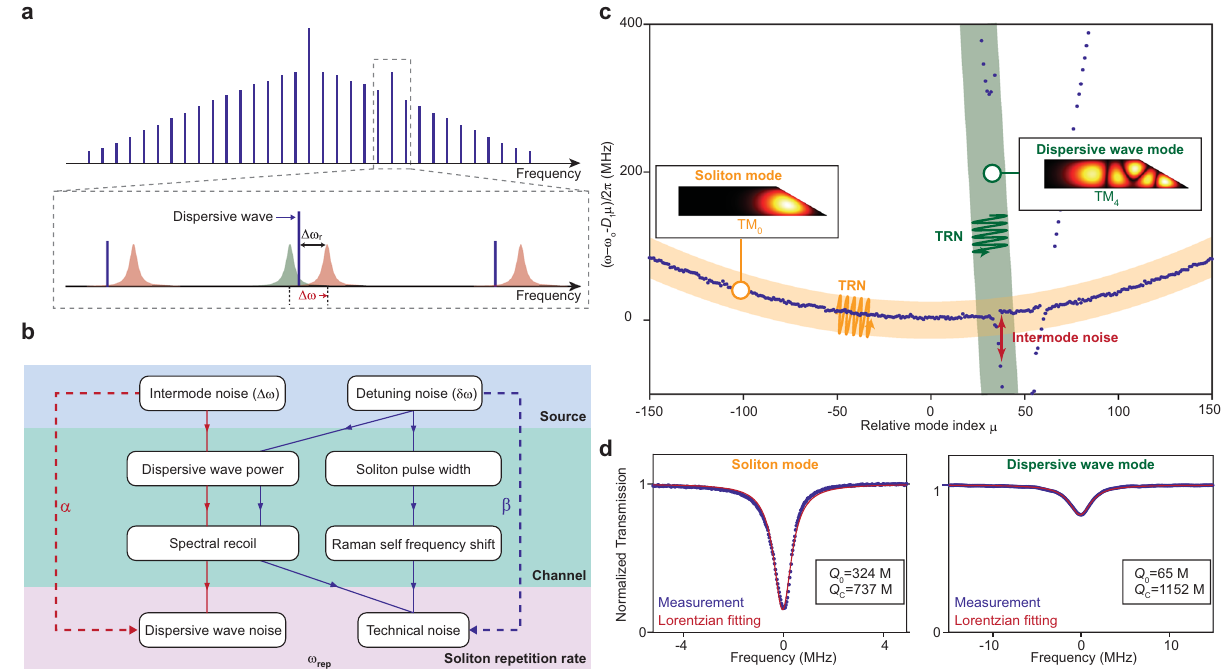
Fig. 4 Concept of dispersive-wave-induced noise and identi fi cation of mode families. a Spectral relationship of soliton spectrum to dispersive wave forming mode. Blue lines indicate soliton spectral lines. Red and green shaded regions denote soliton-forming and dispersive-wave resonator modes, respectively. b Left side: physical steps involved in coupling fl uctuations in Δ ω (intermode noise) into soliton repetition rate. Right side: physical steps involved in coupling fl uctuations in δω (detuning noise) into soliton repetition rate. Noise sources (top) are transduced ( α and β coupling channels) into the soliton repetition rate (bottom). Detuning noise results mainly from the pumping laser noise contributing to δω and thereby causes technical noise in the soliton repetition rate. Intermode noise results from fundamental thermo-refractive noise of the dispersive wave and soliton mode frequencies contributing to Δ ω . c Measured mode family dispersion of the microresonator. Numerically simulated cross sections of soliton (TM 0 ) and dispersive wave (TM 4 ) modes are plotted and identi fi ed with the corresponding frequency branches. Orange and green bands (and wavy lines) are suggestive (and highly magni fi ed) fl uctuations induced by thermo-refractive noise (TRN). d Measured transmission spectra of soliton and dispersive wave resonator modes. The intrinsic ( Q 0 ) and coupling ( Q C ) Q -factors are extracted by fi tting the Lorentzian lineshapes and transmission